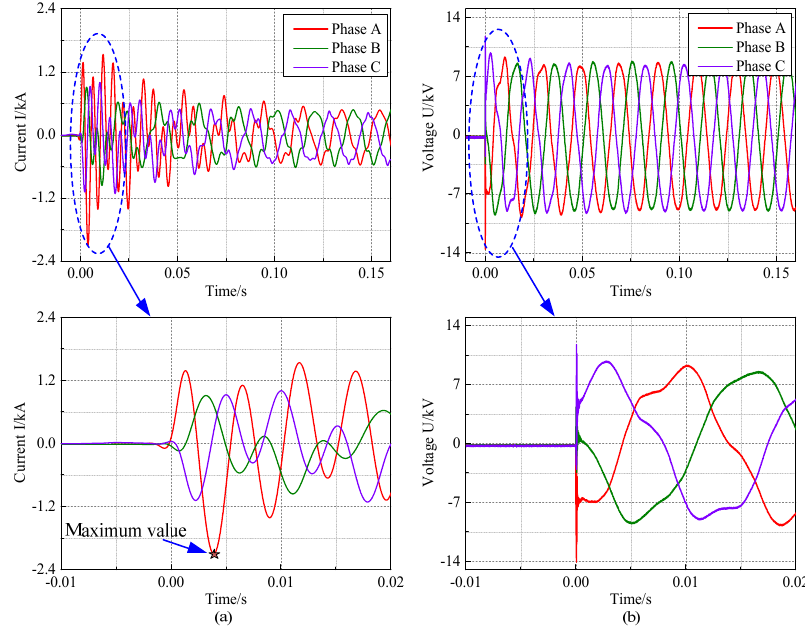
Figure 9. Waveforms of the closing current and capacitor voltage in Case 2. ( a ) Current waveform; and ( b ) voltage waveform.